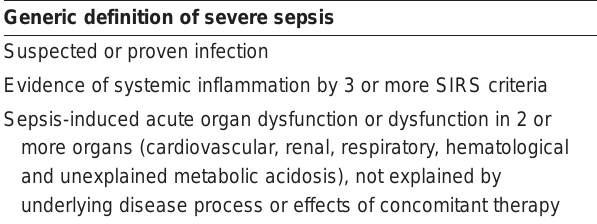
TABLE 3 Practical definition of severe sepsis for clinical treatment with recombinant human activated protein C Generic definition of severe sepsis